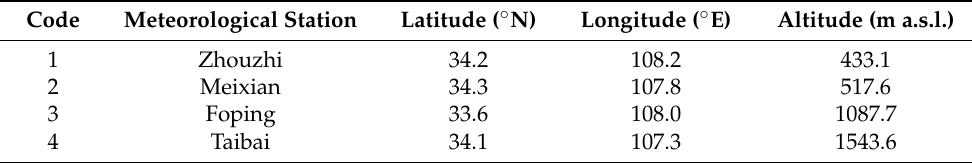
Table 1. Description of the meteorological stations around Mt. Taibai.